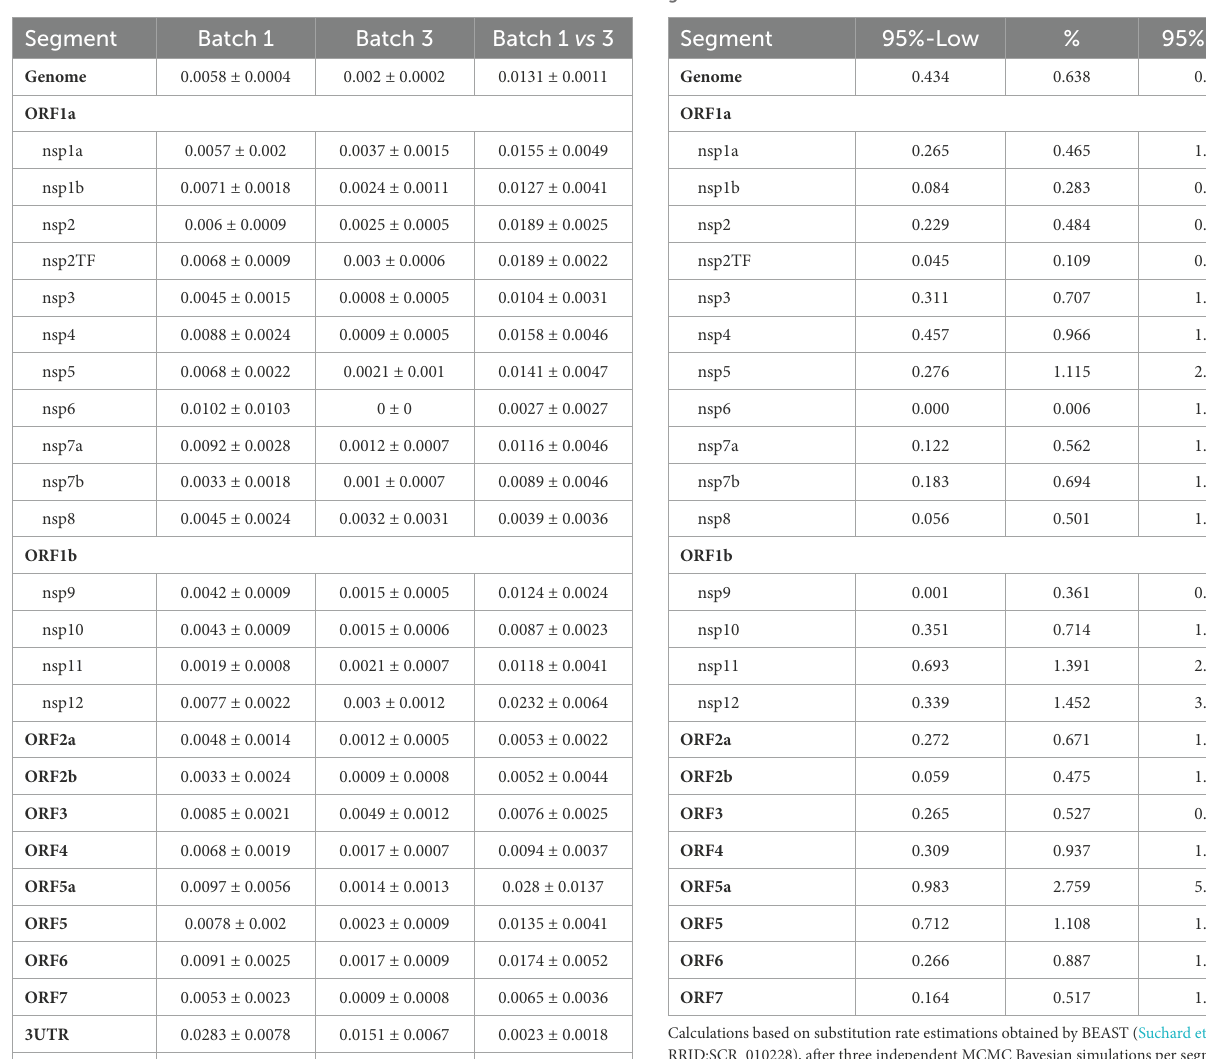
TABLE 1 Similarities ( p -distance ± standard error) within and between Batch 1 and 3.